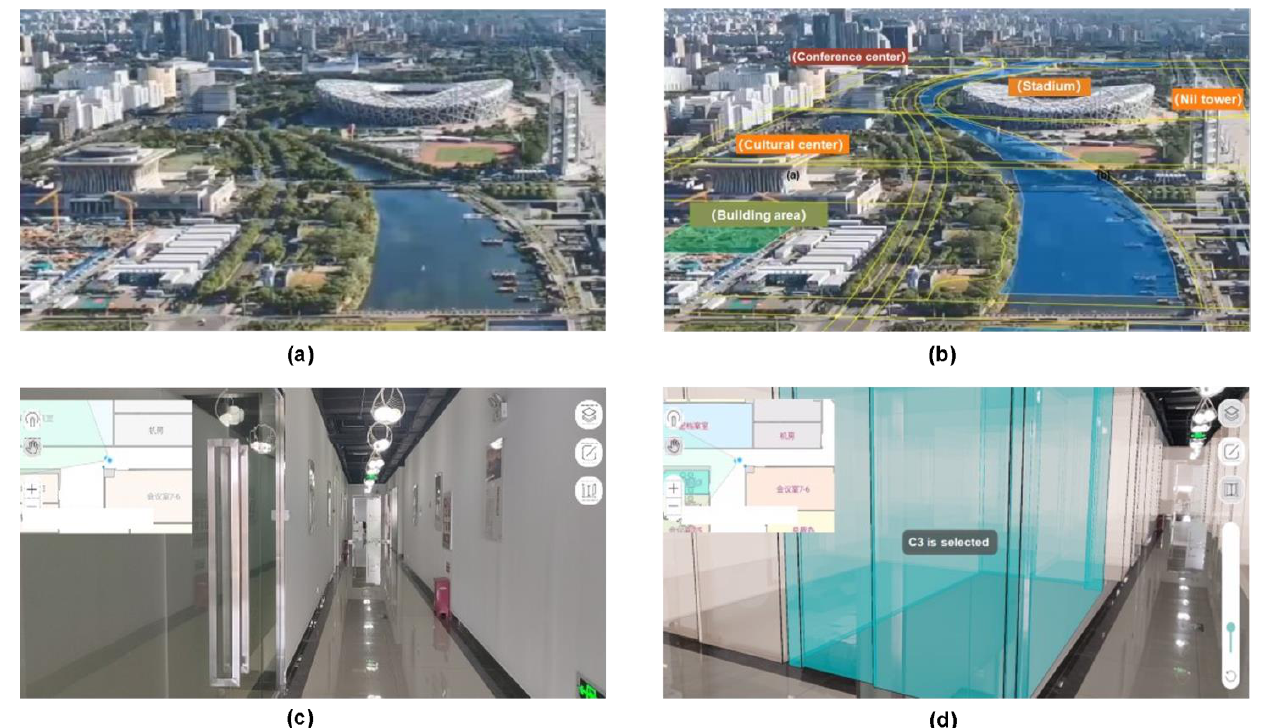
Figure 9. Visualization prototype of AR map symbols based on computer vision camera imaging principle: ( a ) Original display area outdoors; ( b ) Visualization of map symbols in outdoor augmented reality; ( c ) Original display area indoors; ( d ) Visualization of map symbols in indoor augmented reality.